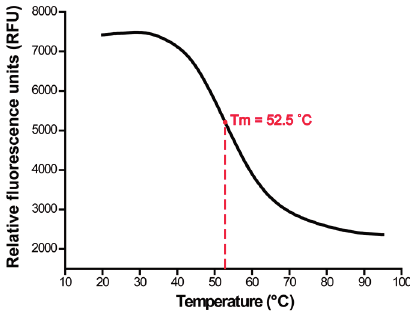
Figure 2. Melt curve of the primer DNA modified on gold nanowires. The temperature was increased gradually by 0.5 °C from 20 to 95